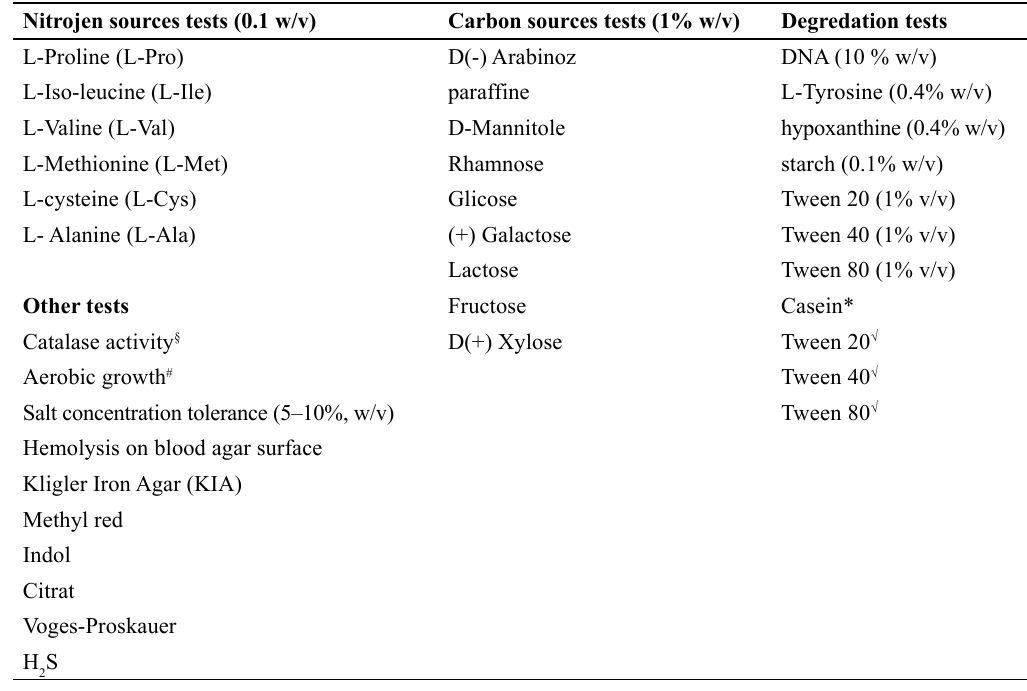
Table 1. The microbiological analyses applied to the test microorganisms